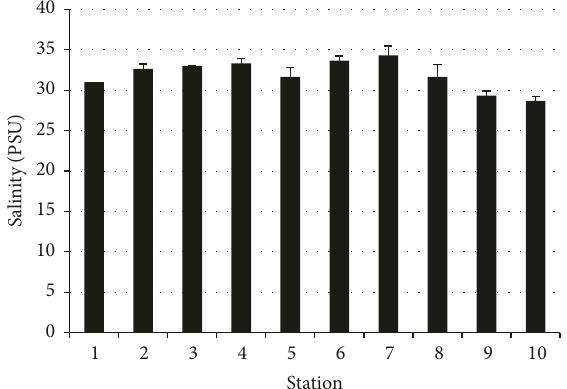
Figure 7: Mean salinity from every